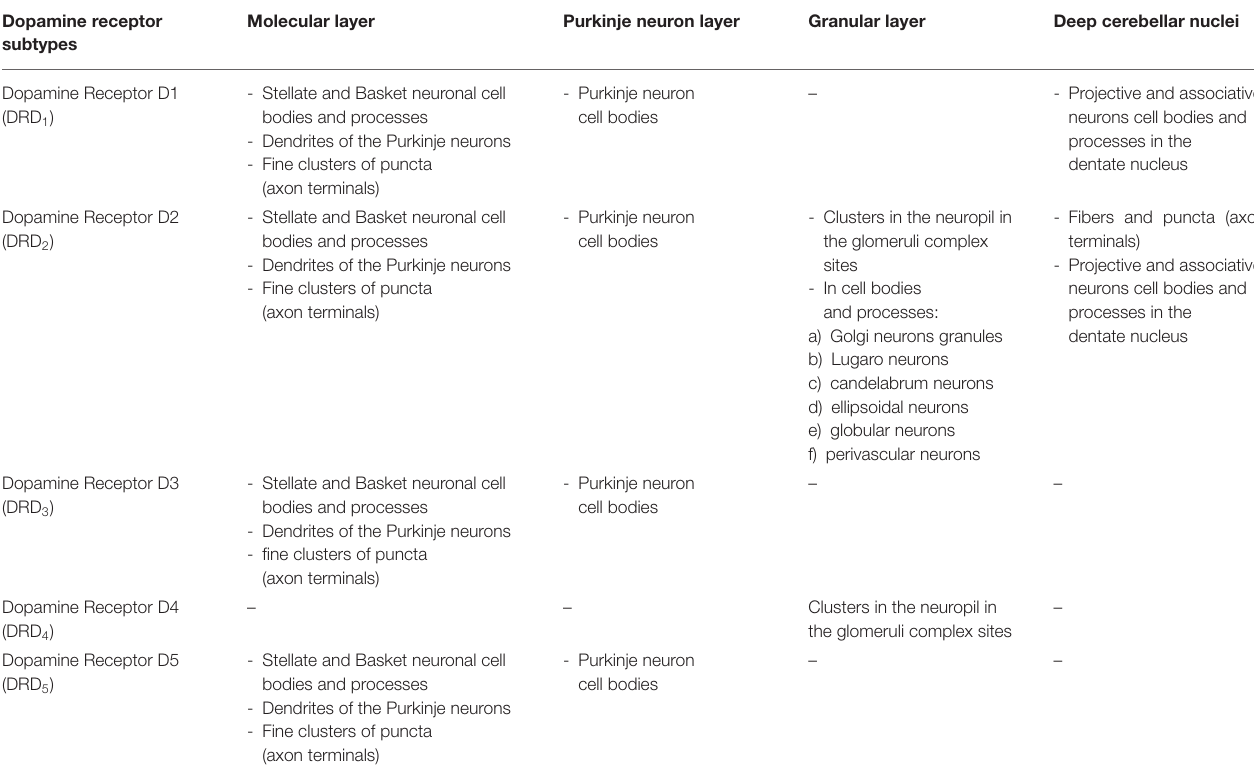
TABLE 2 | Distribution of the dopaminergic receptor subtypes in the mammalian cerebellum. Dopamine receptor